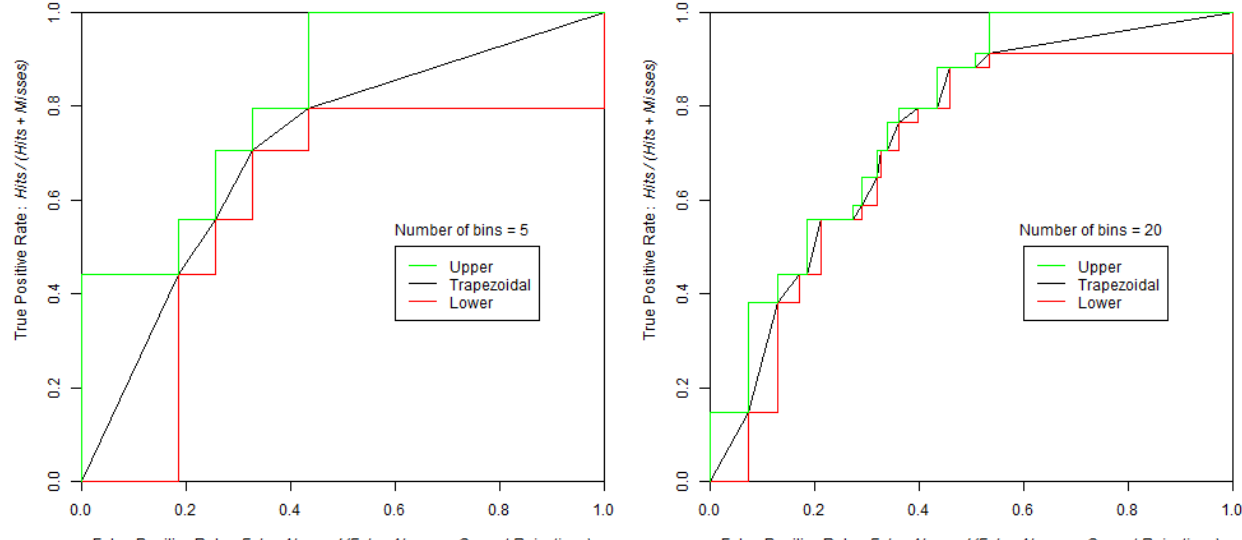
Figure 10. Trapezoidal, lower and upper ROC curves from the same probability map with 0.05 ( Left ) and 0.2 ( Right ) slicing increments. When the threshold increment is 0.2, the number of bins is 5.When the threshold increment is 0.05, the number of bins is 20.